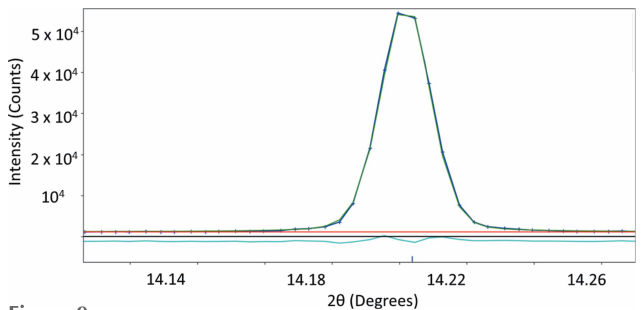
Figure 9 Silicon diffraction profile shape and fitting.